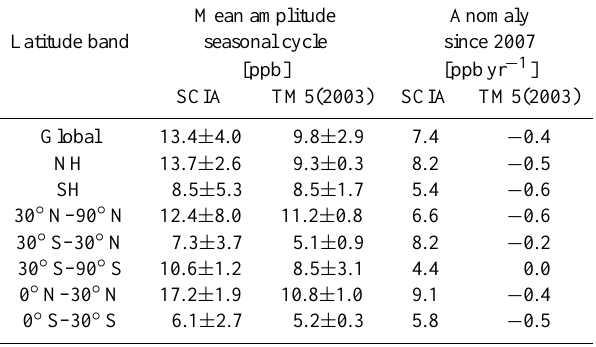
Table 3. Mean amplitude of seasonal cycle and observed annual anomaly since 2007 for SCIAMACHY and TM5 XCH 4 for the two hemispheres and other latitude bands. The anomaly of the model (2003 repeated) is an estimate of the impact of sampling because it is expected to be zero and is therefore a lower bound of the error of the SCIAMACHY anomaly.